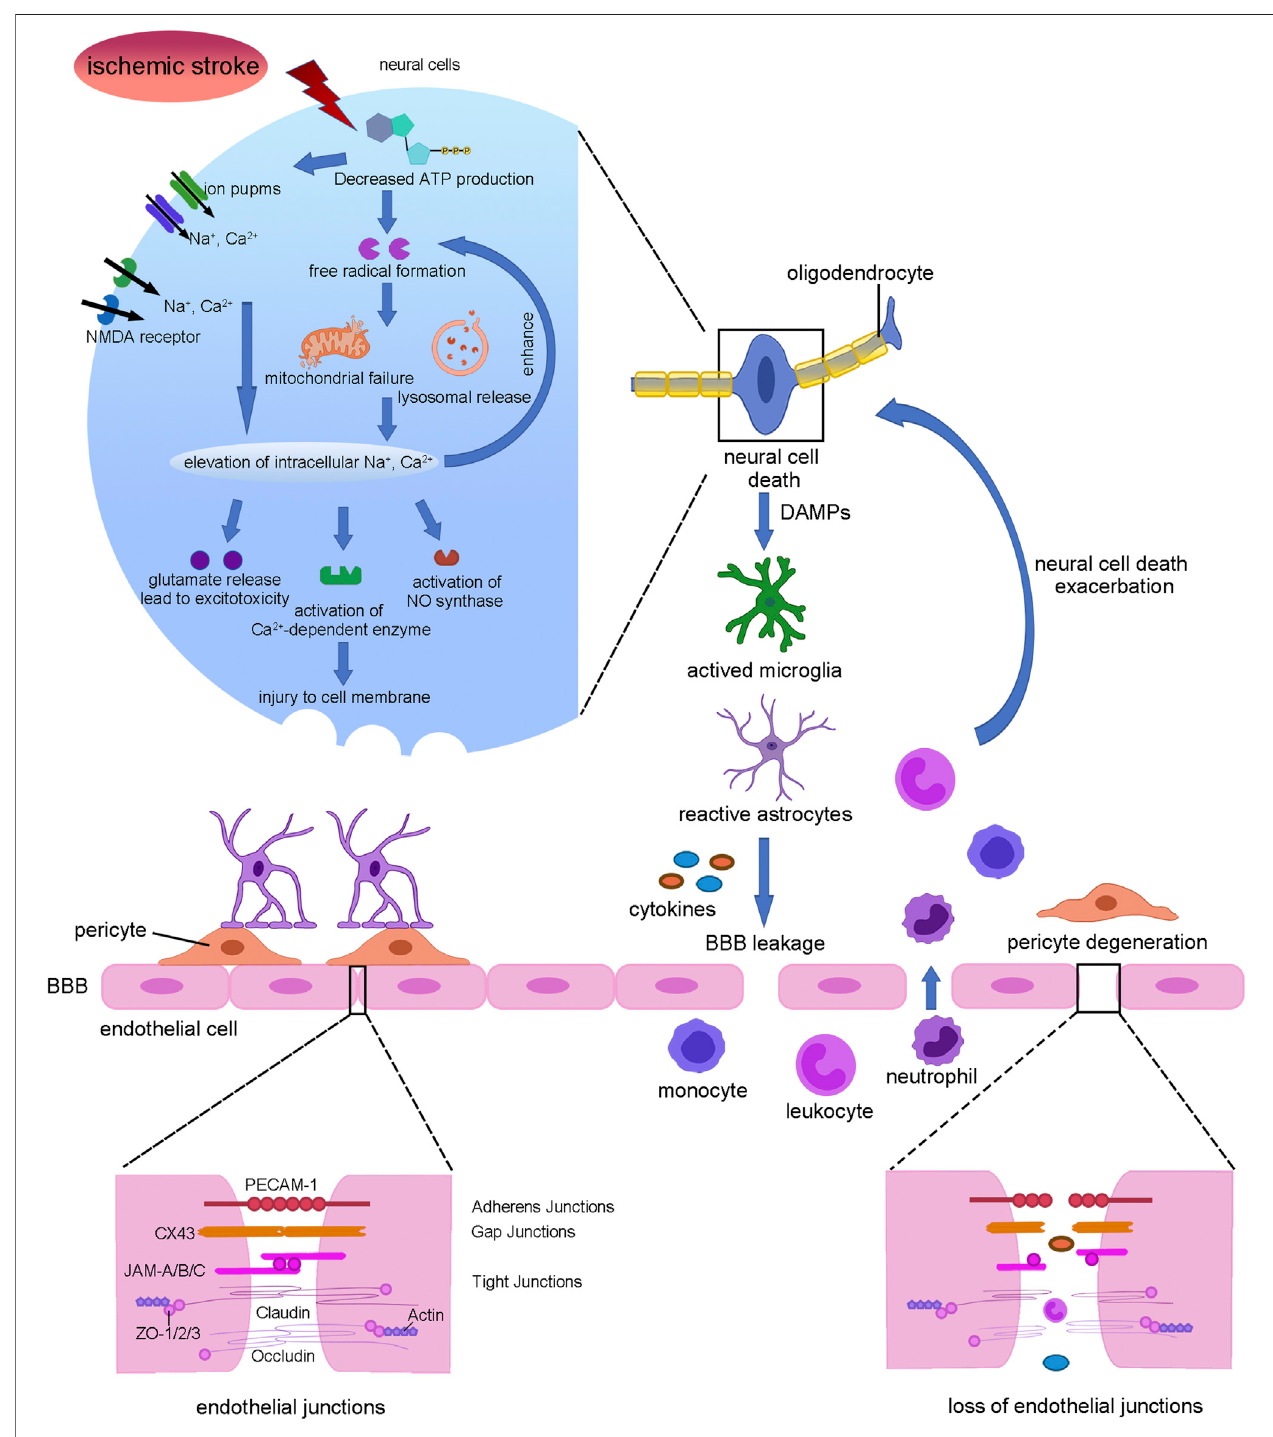
FIGURE 1 | Summary of stroke pathophysiology. Interruption of blood fl ow leads to neural cell death which release DAMPs to activate microglia and astrocytes which secreting cytokines. Then pericyte was degenerated and endothelial tight junctions were lost, leading to BBB leakage. Further, monocyte, leukocyte, and neutrophil in fi ltration from blood exacerbated neural cell death and demyelination.